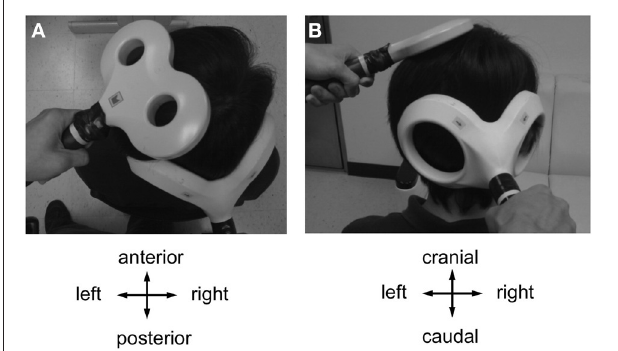
FIGURE 2 | Coil positions for cerebellar-motor cortical inhibition (CBI) and CB → M1 PAS (A, view from above; B, view from behind). A double cone coil was placed over the midpoint of the inion and the right mastoid process for stimulation of the right lateral cerebellum. The coil was oriented to induce an upward current in the cerebellum. A figure-of-eight coil was used to stimulate the left M1 HAND . The coil was oriented to induce a current in M1 directed from posterior-lateral to antero-medial. Motor-evoked potentials were recorded from the first dorsal interosseous muscle of the right